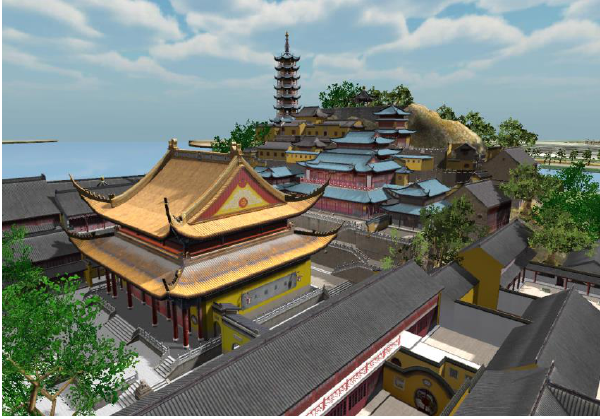
Figure1. A landscape of 3D Jinshan